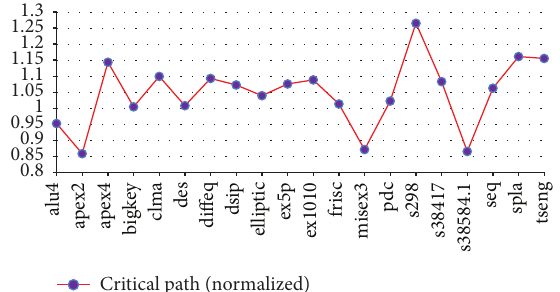
Figure 3: Comparative results of critical path for diffusion based placement algorithm fixed approach normalized to the respective results from VPRs placement algorithm for cluster size 𝑁 = 4 .